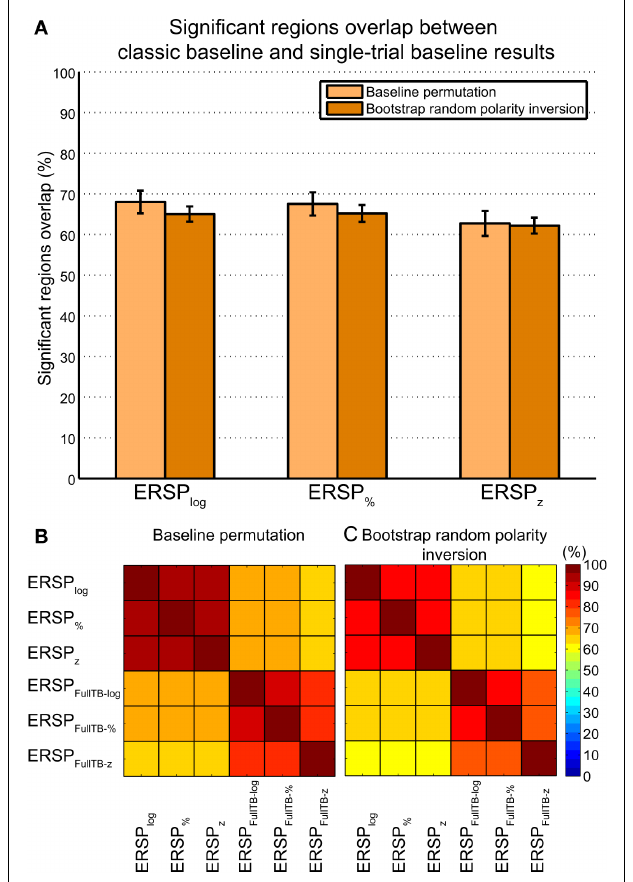
FIGURE 8 |Average percentage of overlap of significant regions between all pairs of ERSP method for 14 subjects. The method for computing percentage of overlap is indicated in the text. (A) Bar chart of the percentage of overlap between the significant regions of ERSP using classical baseline correction and ERSP using single-trial correction. Error bars show the SE of the mean. (B) Overlap of ERSP significant regions for the baseline permutation statistical method. (C) Overlap of significant regions for the bootstrap random polarity inversion statistical method.